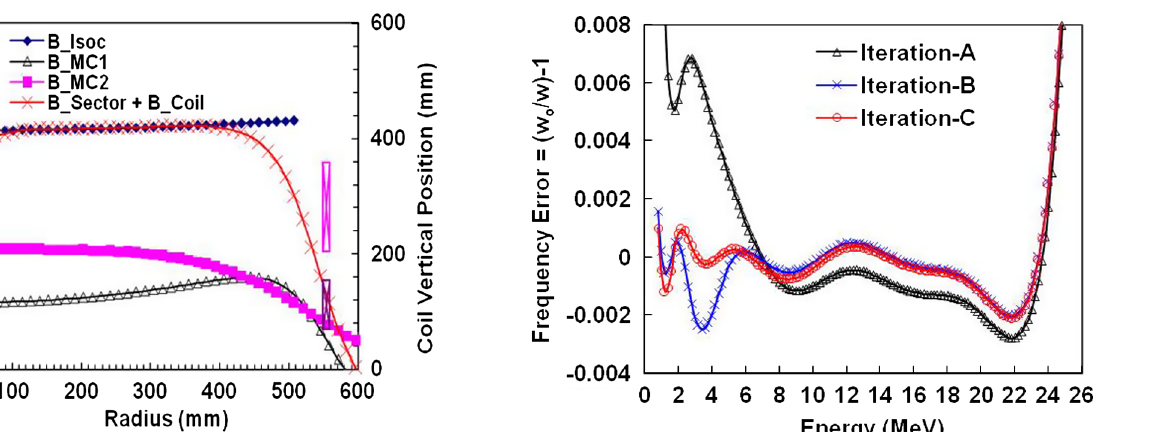
FIG. 10. The graphs show three stages of iterations during minimization of frequency error by fine-tuning the average magnetic field.